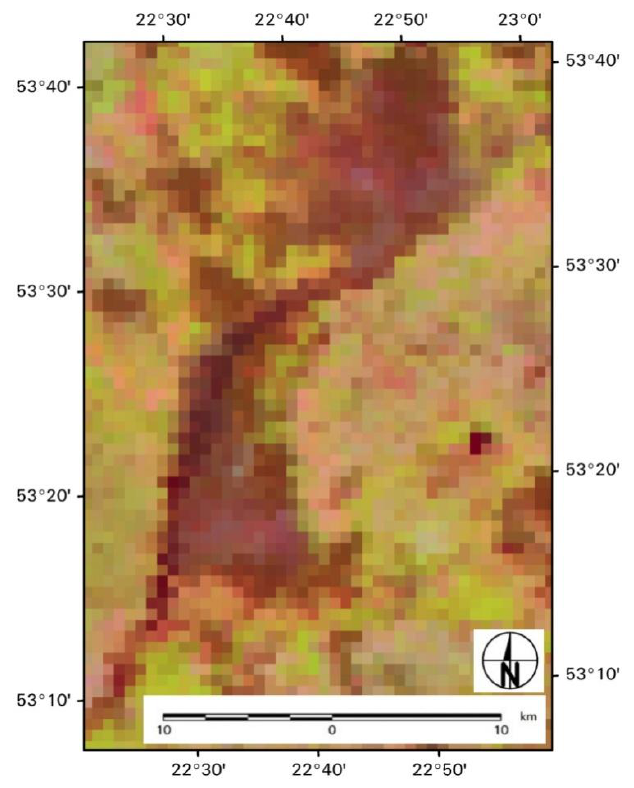
Figure 4. Red, Green, Blue (RGB) (4, 2, 1) composition of AVHRR image acquired on 24 April 2008.